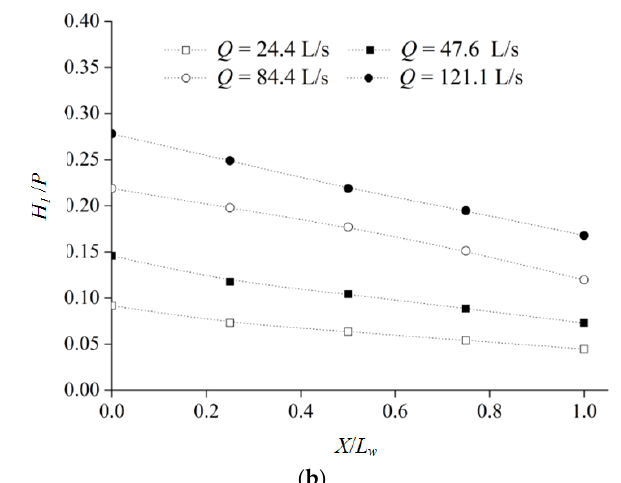
Figure 4. Comparison of water-surface profiles: ( a ) with FGP ( β = 0.51, θ = 15°); ( b ) without FGP ( β = 1) ( Q —the discharge of the weir, H 1 —water depth of the weir crest).